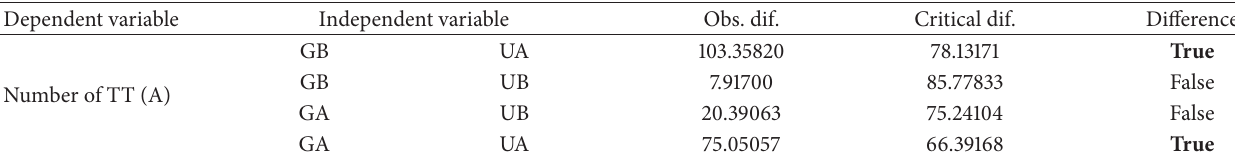
Table 7: Multiple comparisons considering the types of R&D.